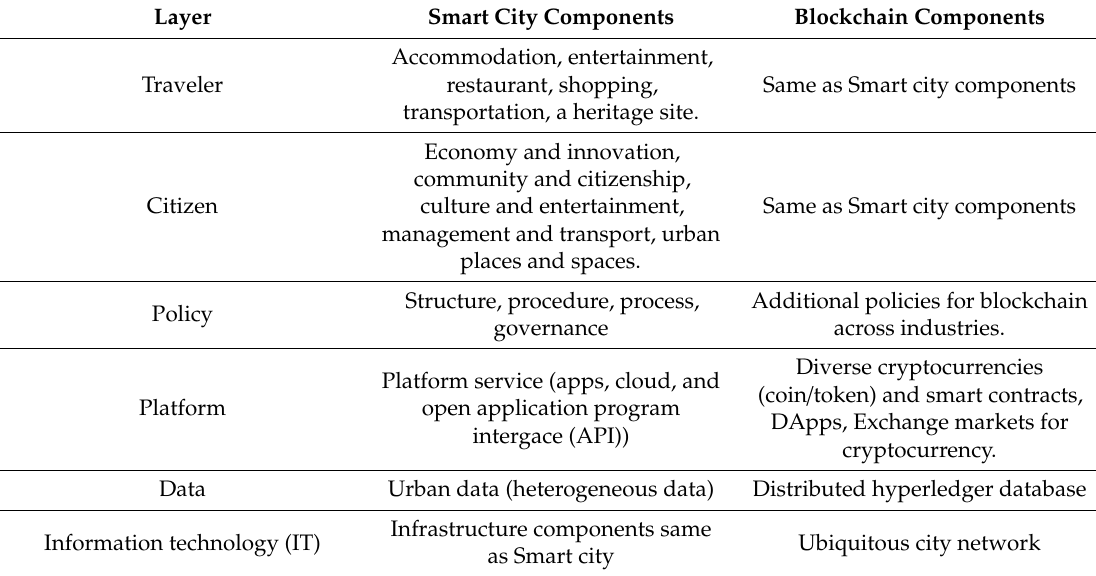
Table 3. Smart city and tourism architecture with blockchain [16] (p. 4).